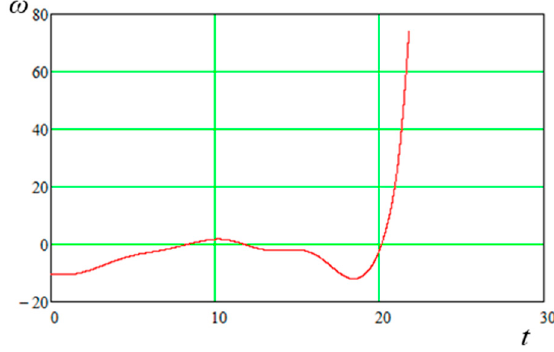
Figure 11. Osculating argument for the perigee of a transfer orbit as a function of flight time [undim.].